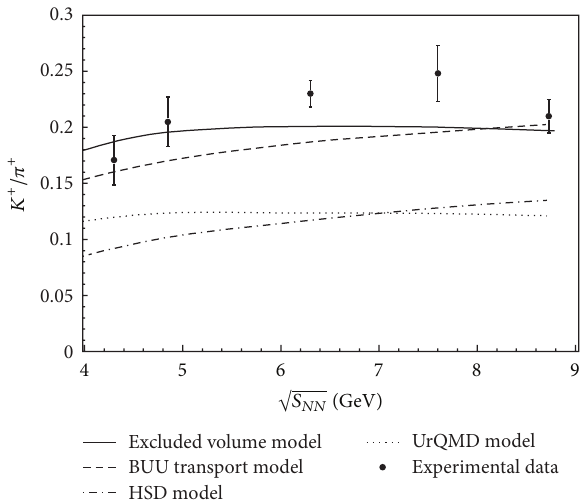
Figure 5: Variation of 𝐾 + /𝜋 + ratio with respect to √ 𝑠 𝑁𝑁 . The results obtained from HSD and UrQMD are taken from [29]. The results obtained from BUU transport model are extracted from [44]. Experimental data is taken from [30–35].